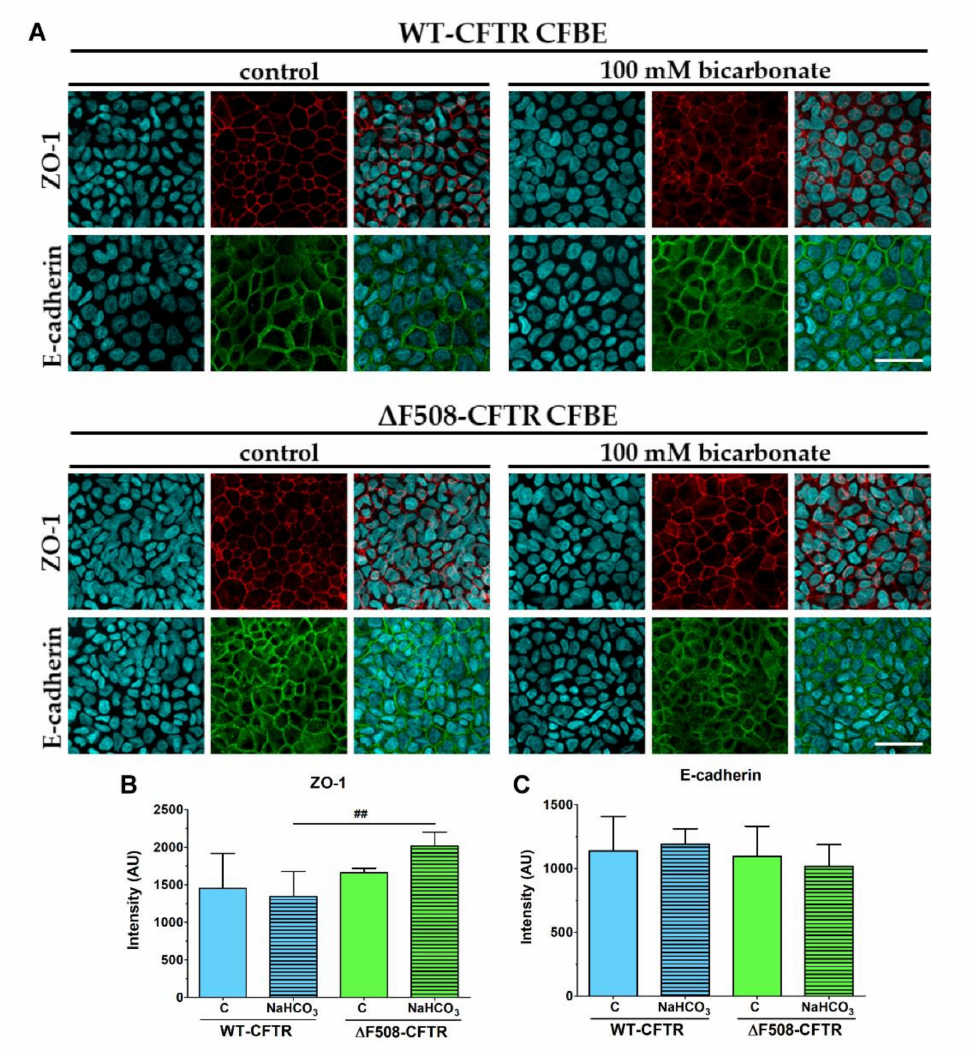
Figure 11. The e ff ect of sodium bicarbonate on the junctional morphology of CFBE cells. Immunostaining of the co-culture model for junction proteins zonula occludens-1 (ZO-1) and E-cadherin ( A ) after treatment with culture medium containing 26 mM (control group) or 100 mM bicarbonate treatment (24 h). The mean pixel intensity of ZO-1 ( B ) and E-cadherin ( C ) immunostainings at the junctional area. Values are presented as means ± SD, n = 3–6 / group. Statistical analysis: 2-way ANOVA and Bonferroni test. ## p < 0.01 compared to the wild-type epithelial cells. Red color: immunostaining for ZO-1. Green color: immunostaining for E-cadherin. Cyan color: cell nuclei. Bar: 40 µ m. 2.7. The E ff ect of Bicarbonate on the Resting Intracellular pH of CFBE Cells The resting intracellular pH (pH i ) of the untreated WT-CFTR CFBE cells was found to be 7.48 ± 0.04 which was not changed by treatment with 100 mM NaHCO 3 . The cells expressing the mutant CFTR channel showed significantly elevated pH i (7.74 ± 0.06) as compared to the WT cells (Figure 12). This finding is in accordance with a previous observation of Walker et al., who found that the intracellular pH of CFTR-KO crypt epithelial cells is more alkaline when compared to the wild-type cells [24]. Importantly, we found that NaHCO 3 treatment of ∆ F508-CFTR CFBE cells decreased the pH i to the level of the pH i measured in WT cells, indicating a beneficial e ff ect on the mutant